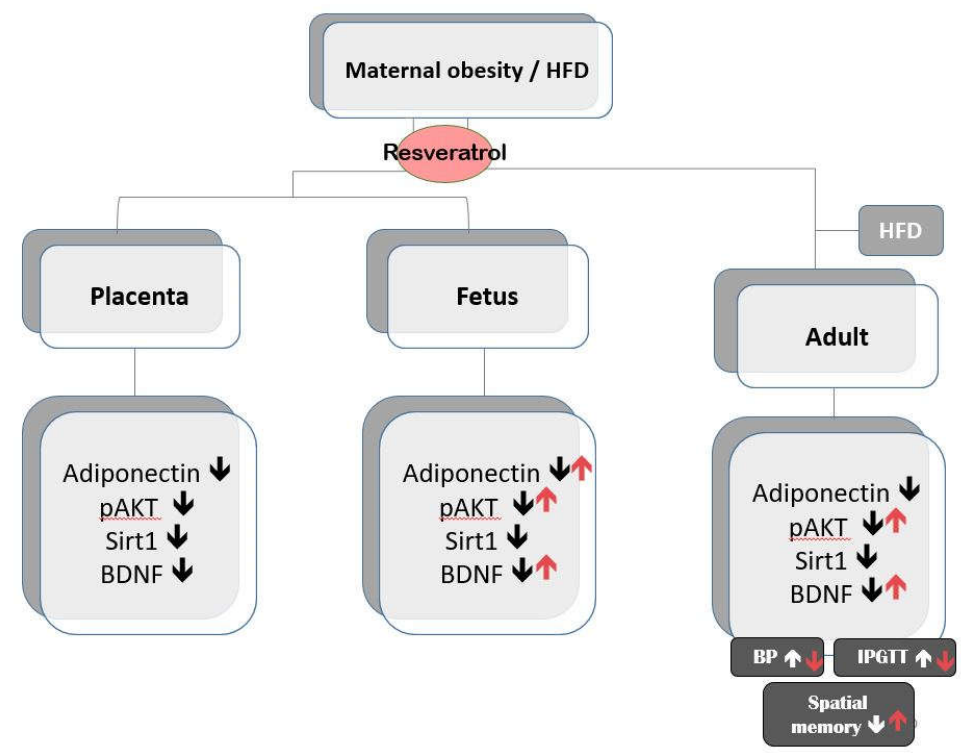
Figure 8. A summary of the effects of maternal resveratrol on the maternal high-fat diet/obesity with or without postnatal high-fat diet. ↑ indicates up-regulation; ↓ indicates down-regulation.